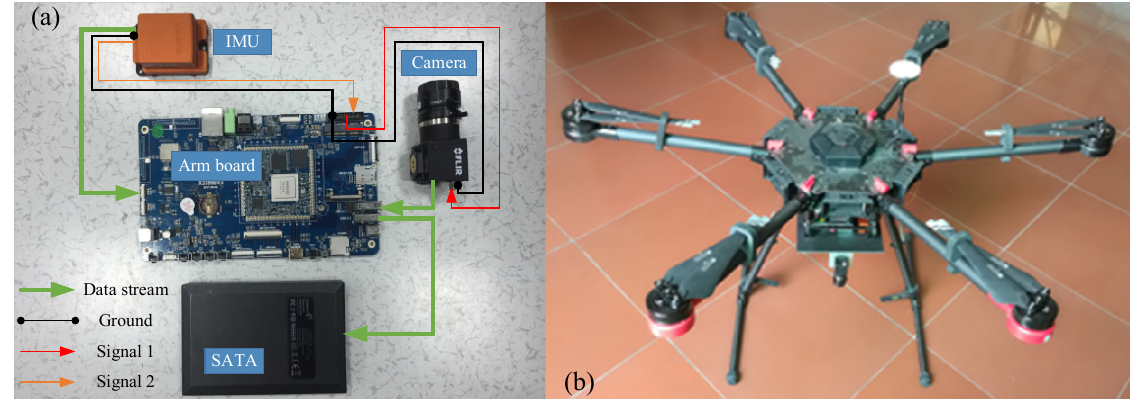
Figure 1. System description. (a)The green line represents the data stream. The black line is the ground wire. The red and orange wires represent the synchronization signals. (b) Our UAV platform.